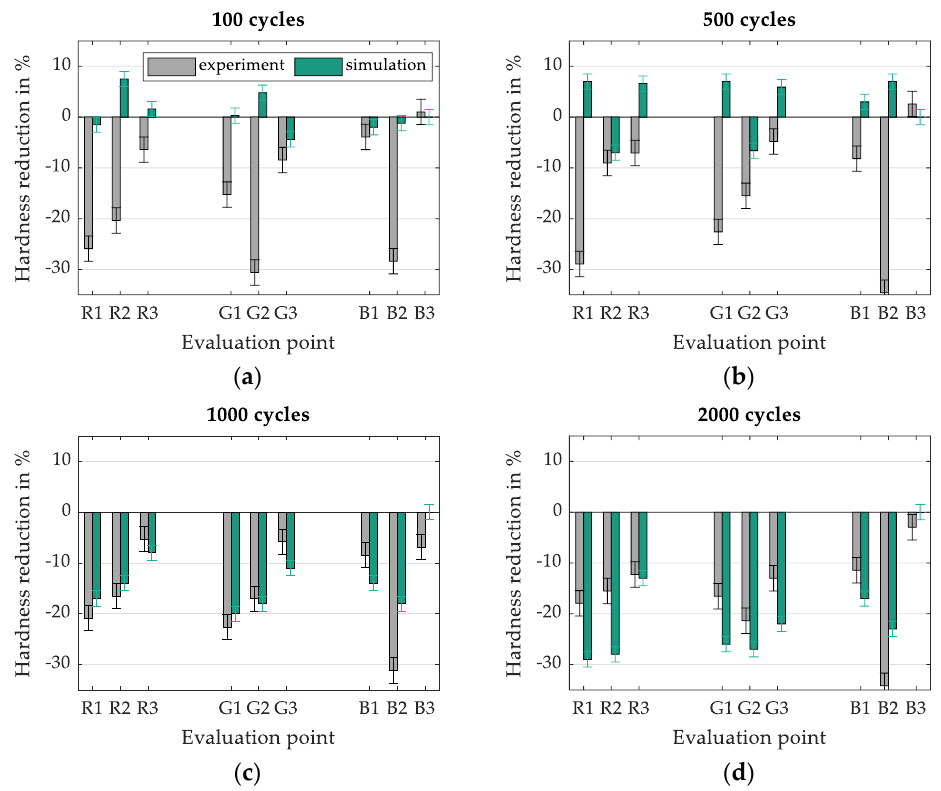
Figure 18. Local evaluation of the measured hardness compared to the numerical results after ( a ) 100 cycles, ( b ) 500 cycles, ( c ) 1000 cycles and ( d ) 2000 cycles.